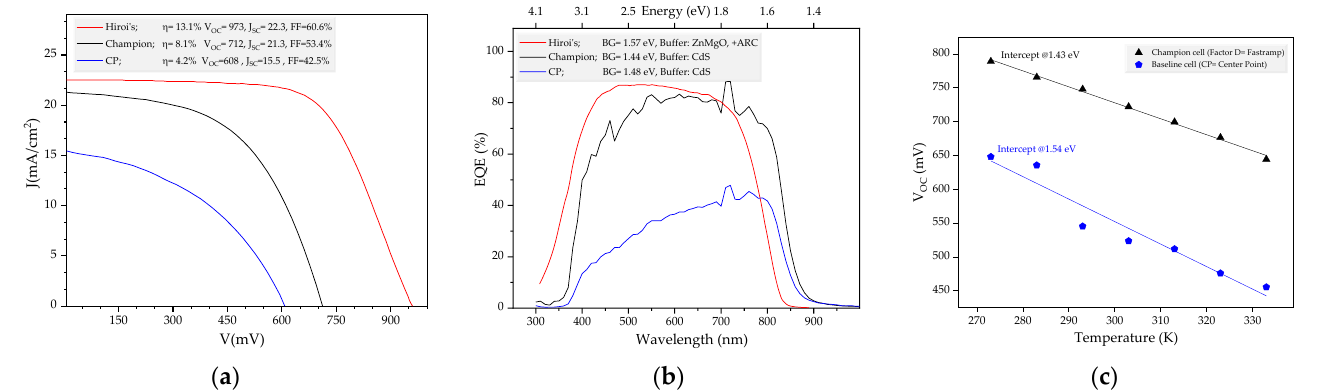
Figure 5. J-V ( a ), EQE ( b ) and temperature-dependent V OC ( c ) of this work’s baseline and best cells.